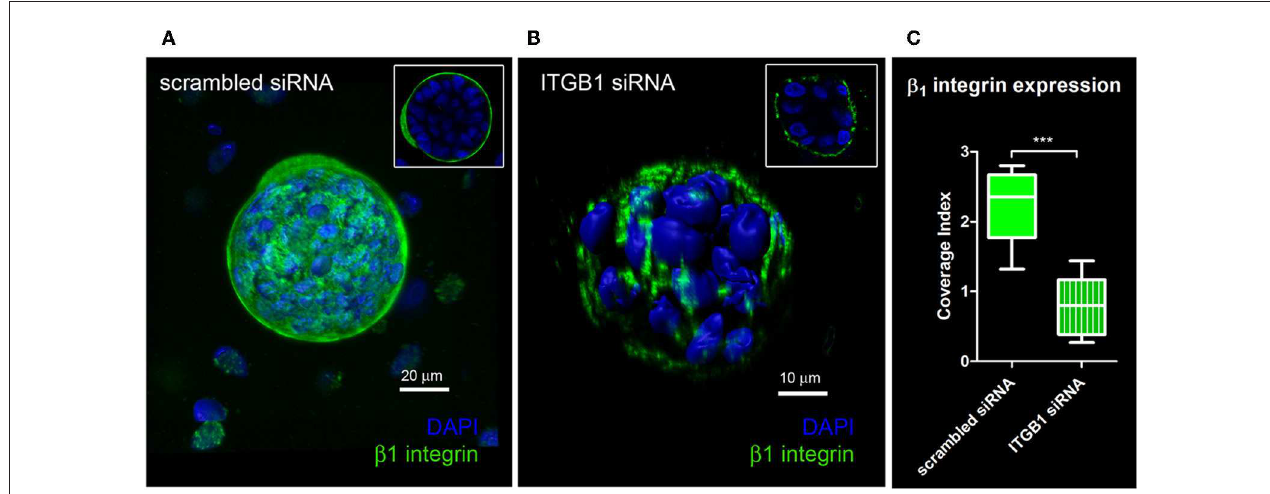
FIGURE 5 | Quantification of knockdown of β 1 integrin in hS/PC microstructures. hS/PC microstructures formed in HA-based hydrogels and were transfected with scrambled siRNA or ITGB1 siRNA. Immunocytochemistry was used to determine β 1 integrin expression and spatial distribution of β 1 integrin 46h post-transfection.